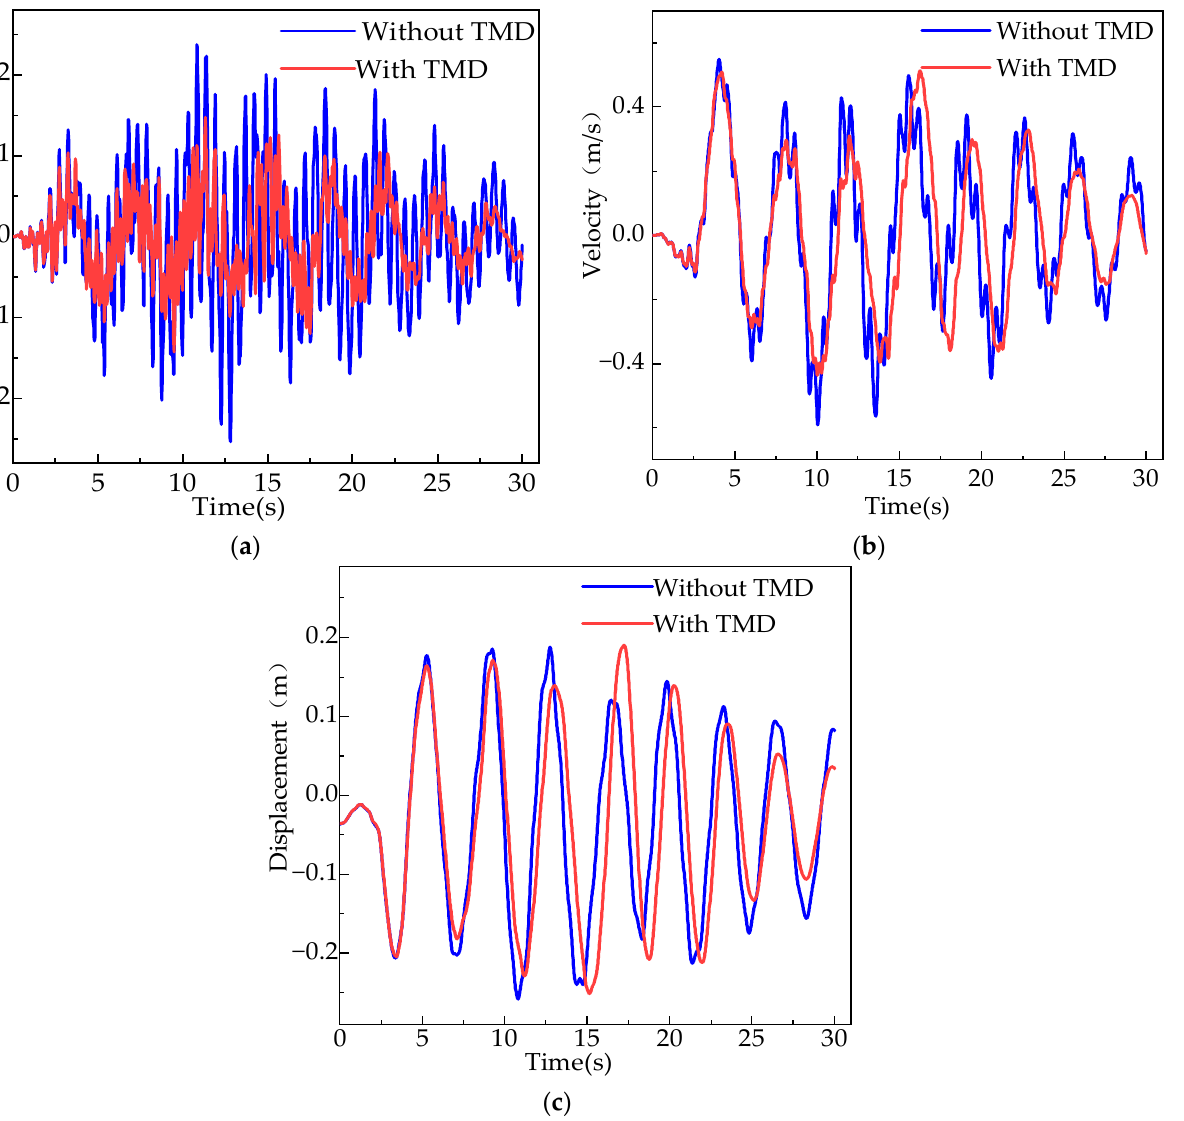
Figure 10. Comparison of acceleration, velocity and displacement at 117 m with and without TMD towers: ( a ) acceleration comparison; ( b ) velocity comparison; ( c ) displacement comparison.